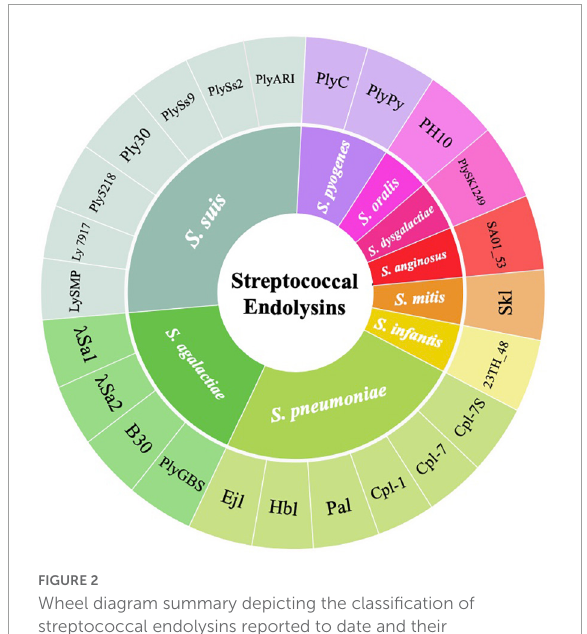
FIGURE2 Wheel diagram summary depicting the classification of streptococcal endolysins reported to date and their corresponding streptococcal species targets.